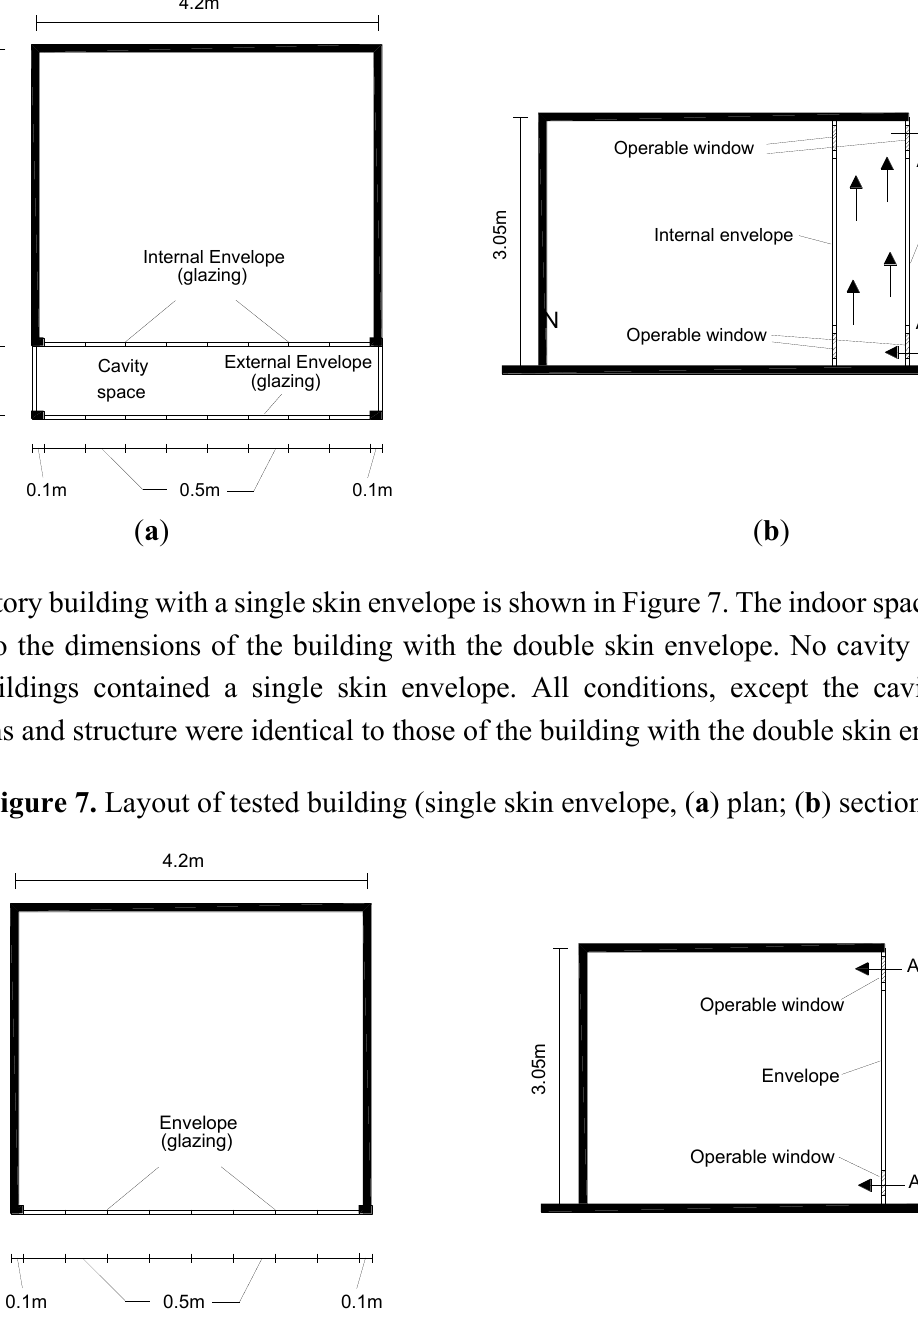
Figure 6. Layout of tested building. Double skin envelope, ( a ) plan; ( b ) section.